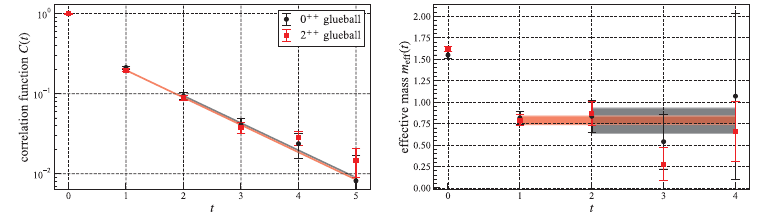
Figure 5. Glueball mass measurement under the eigenmode projection with 0.1 % low-lying FP eigen- modes. Correlation functions are normalized such that C (0) =